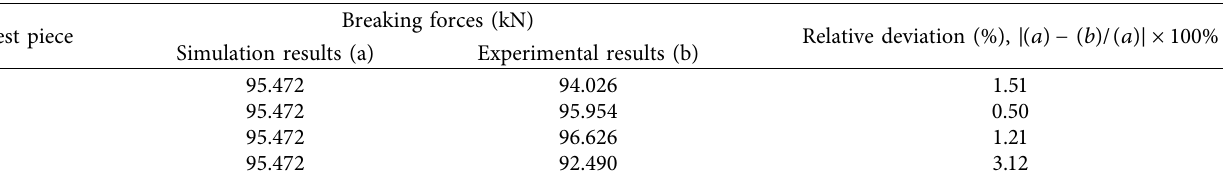
Table 3: Comparison of breaking forces between simulation results and experimental results.